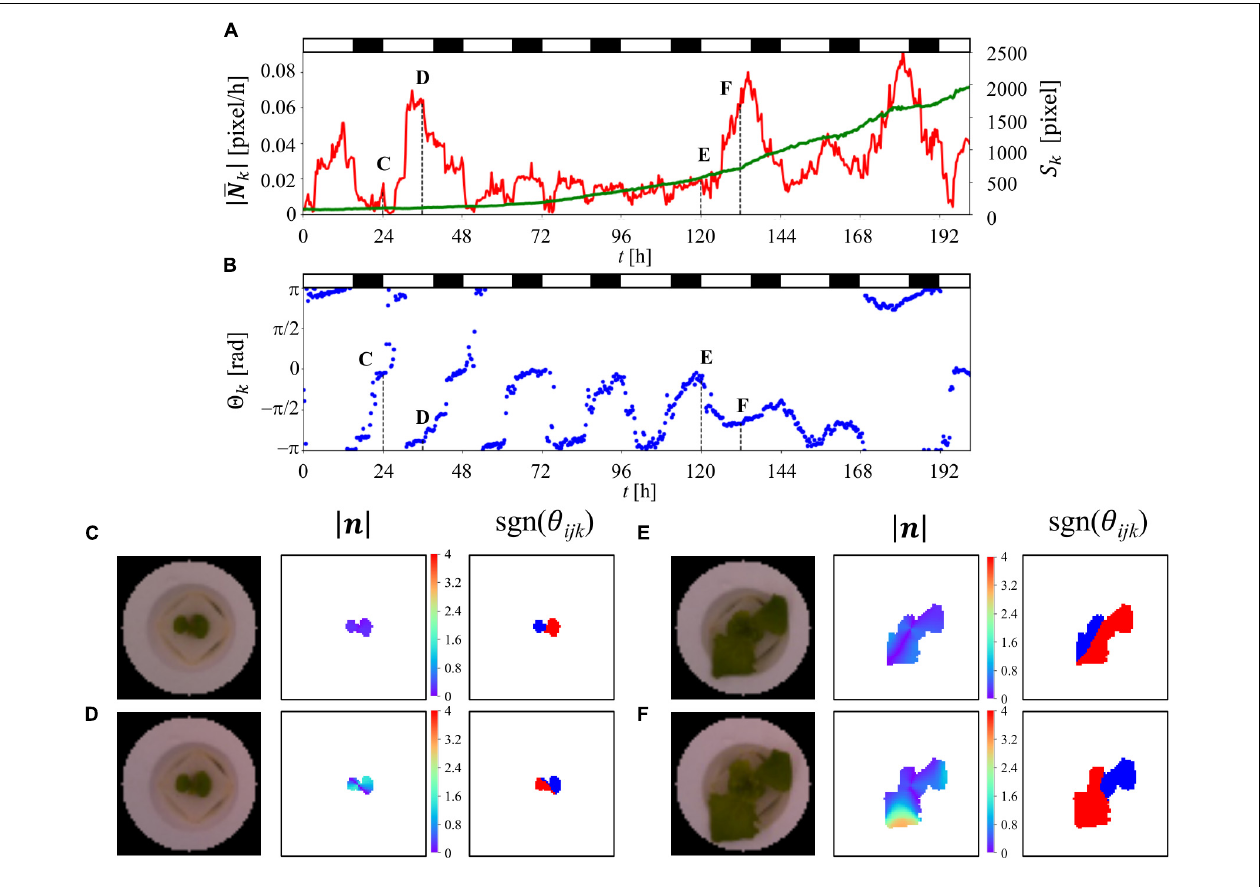
FIGURE 4 | Time-series analysis result for single plant using OF. (A,B) Time-series analysis result for single lettuce from t = 0–201 h. Red, green, and blue lines (cid:12) (cid:12) θ k , respectively. The white and black bar at the top of the figure indicates the light and dark conditions. (C–F) shows the image data and (cid:12) (cid:12) represent (cid:12) N k (cid:12) , S k , and visualization results for (cid:12) (cid:12) n ijk (cid:12) (cid:12) as well as the visualization results for sgn( θ ijk ) at t = 24, 36, 120, and 132 h, respectively. The red part of sgn( θ ijk ) represents the positive-direction vector, relative to the center of the seedling. The blue part of sgn( θ ijk ) represents the negative-direction vector, relative to the center of the